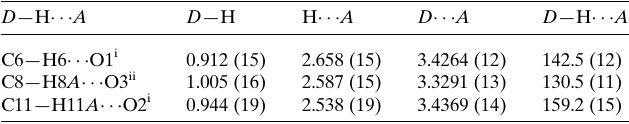
Table 3 Hydrogen-bond geometry (A˚ , (cid:3) ) for 1 .